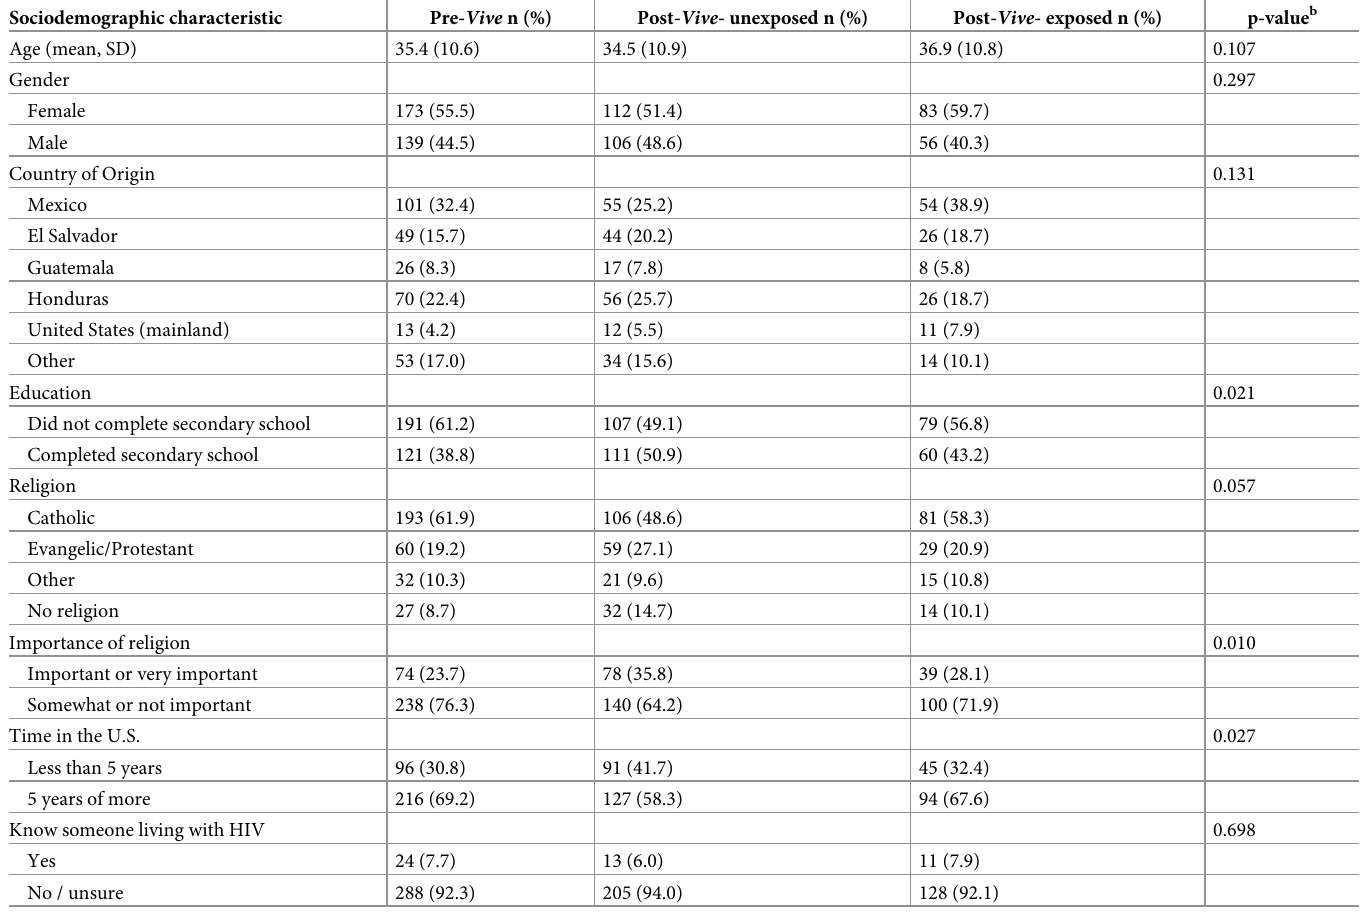
Table 1. Socio-demographic characteristics of the pre- Vive a (n = 312), post- Vive -unexposed (n = 218), and post- Vive -exposed (n = 139) respondents survey respondents. Sociodemographic